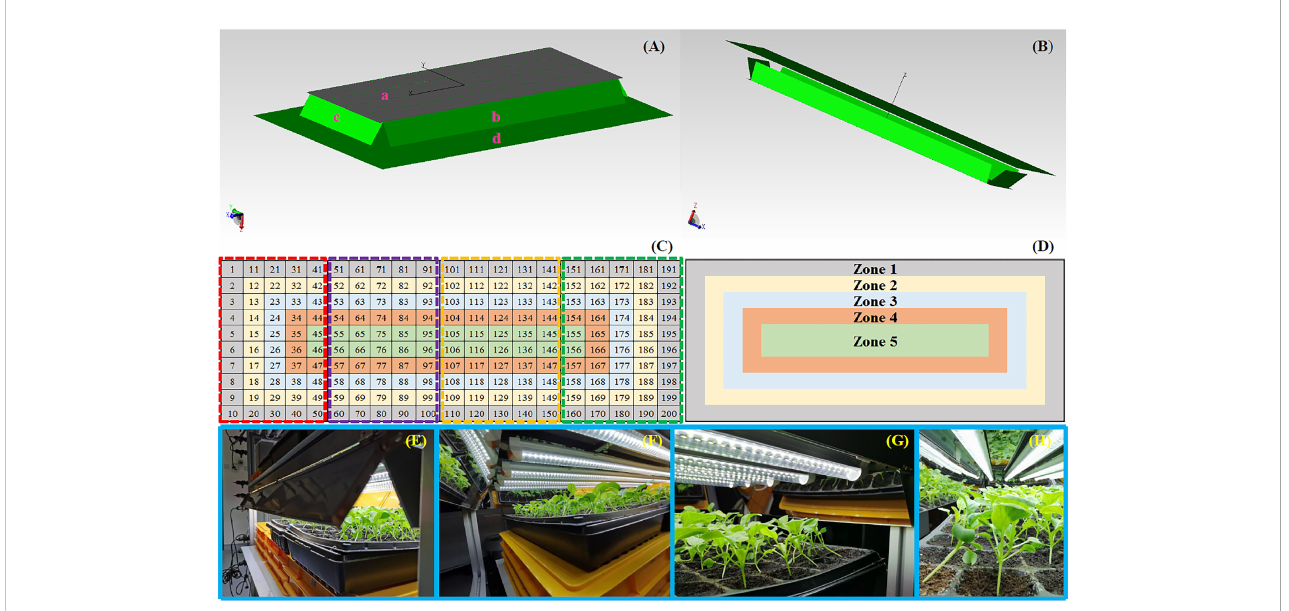
FIGURE 2 (A) Erected and (B) inverted schematic views of the three-dimensional simulative model of the adjustable lampshade-type re fl ector designed by the light simulative software TracePro. (C) Arrangement of four germination trays in the shelf of an indoor farm rack, marking the locations of a total of 200 cavities. (D) De fi nition of fi ve zones on the four germination trays. Performance photos of the adjustable lampshade-type re fl ector observed from the viewing angles of (E) exterior, (F) short-side re fl ective board, (G) long-side re fl ective board, and (H) interior. The dashed rectangles with red, purple, earthy yellow, and green colors in (C) represent tray 1, 2, 3, and 4, respectively. In (A) , a is the lambertian diffuser board, b stands for the long-side simulative re fl ective board, c represents the short-side simulative re fl ective board, and d is the absorber